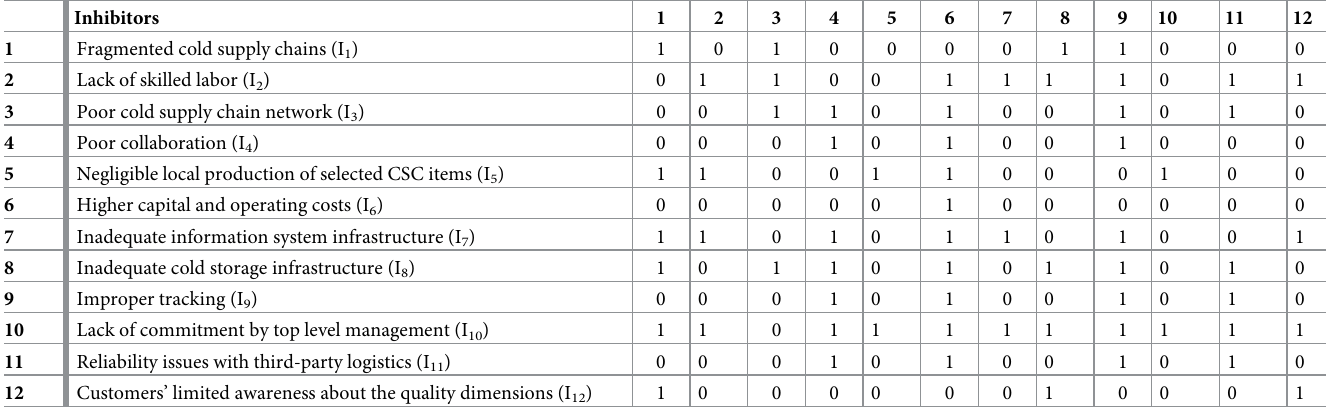
Table 3. Initial reachability matrix developed from the SSIM.